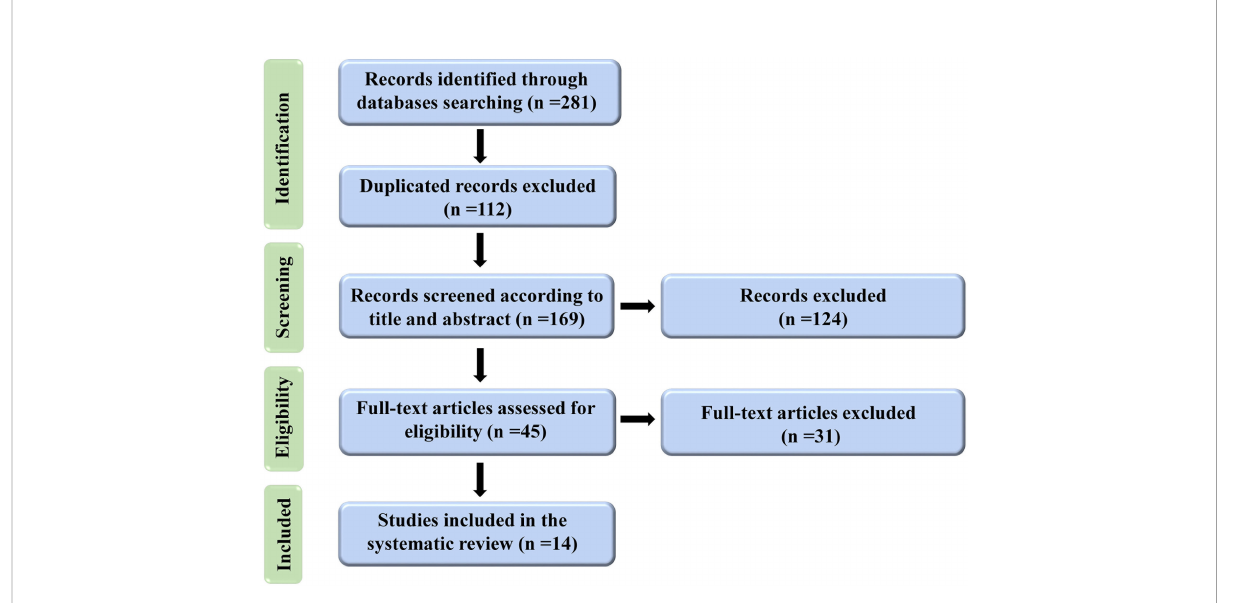
FIGURE 1 Flow diagram representing the selection process for this